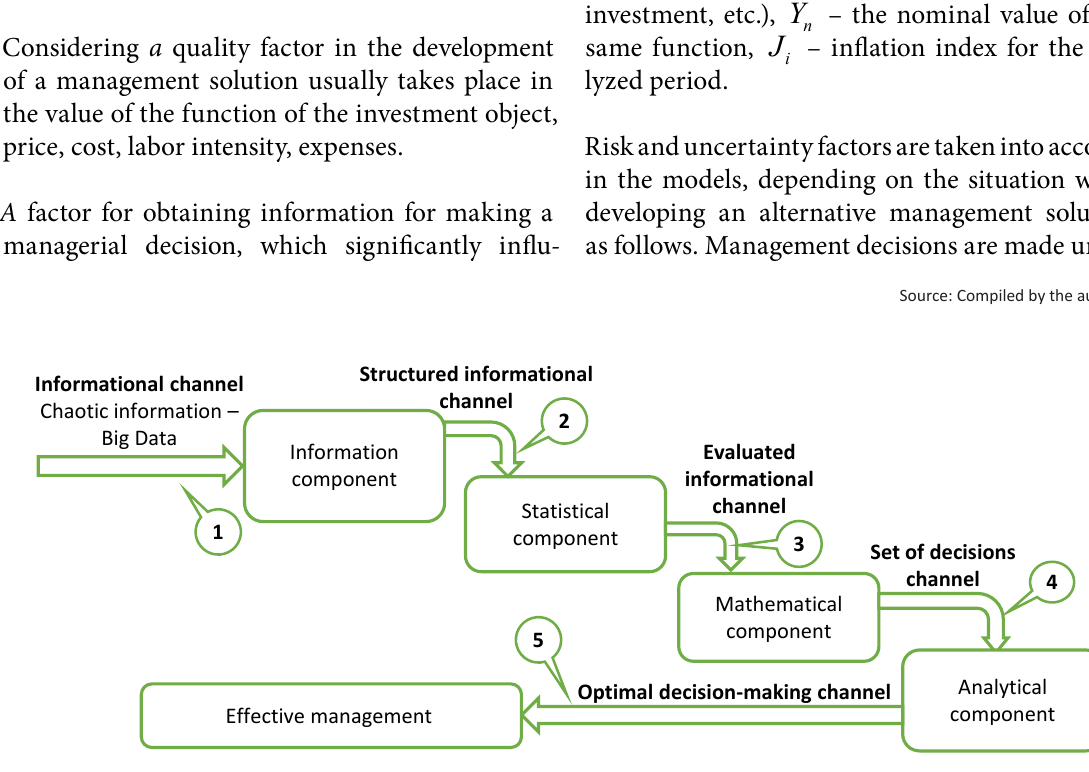
Figure 3. Informational channels structure at the conceptual scheme of the effective